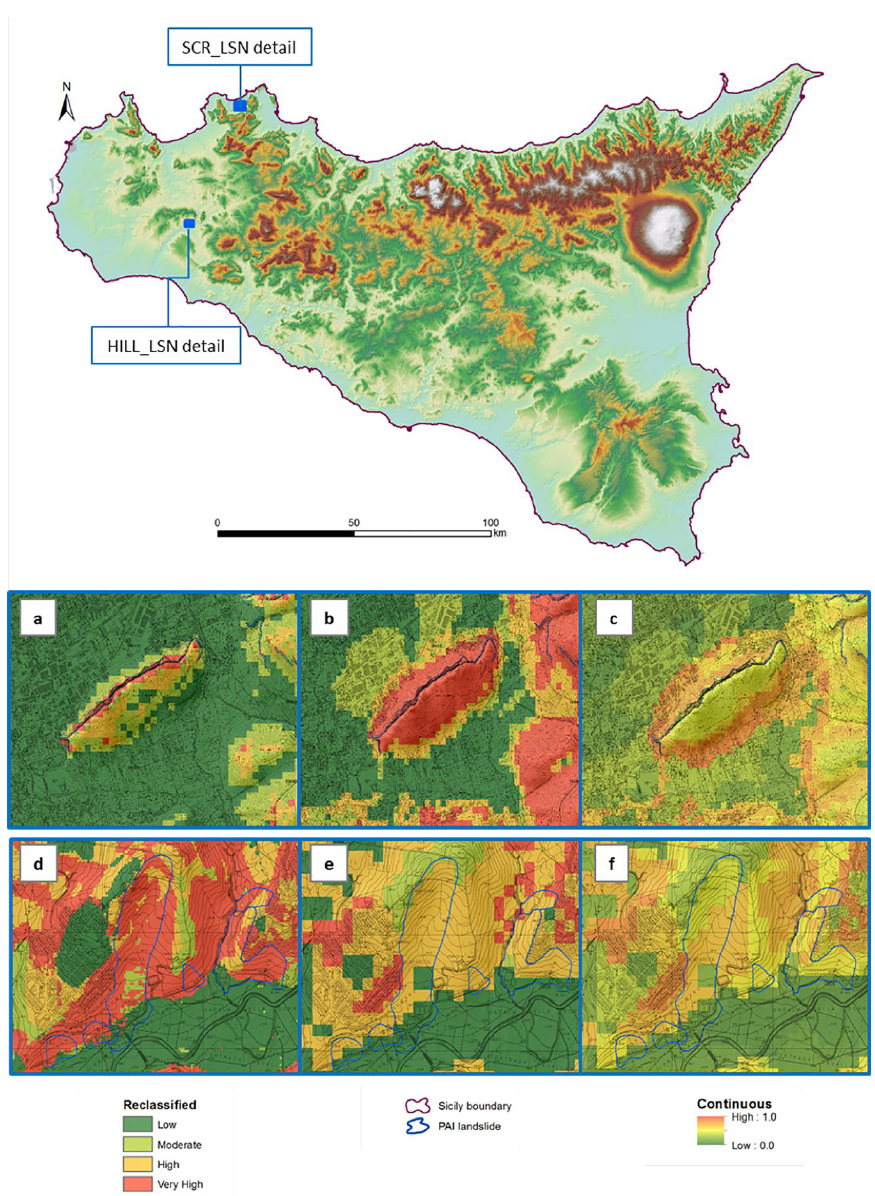
Figure 6. Different classifications of susceptibility values for HILL_LSN ( d , e , f ) and SCR_LSN ( a , b , c ) using BLR ( a , d ) and CA ( b , e ) reclassified. Figures ( c ) and ( f ) show the susceptibility values obtained with the BLR technique and are shown with continuous